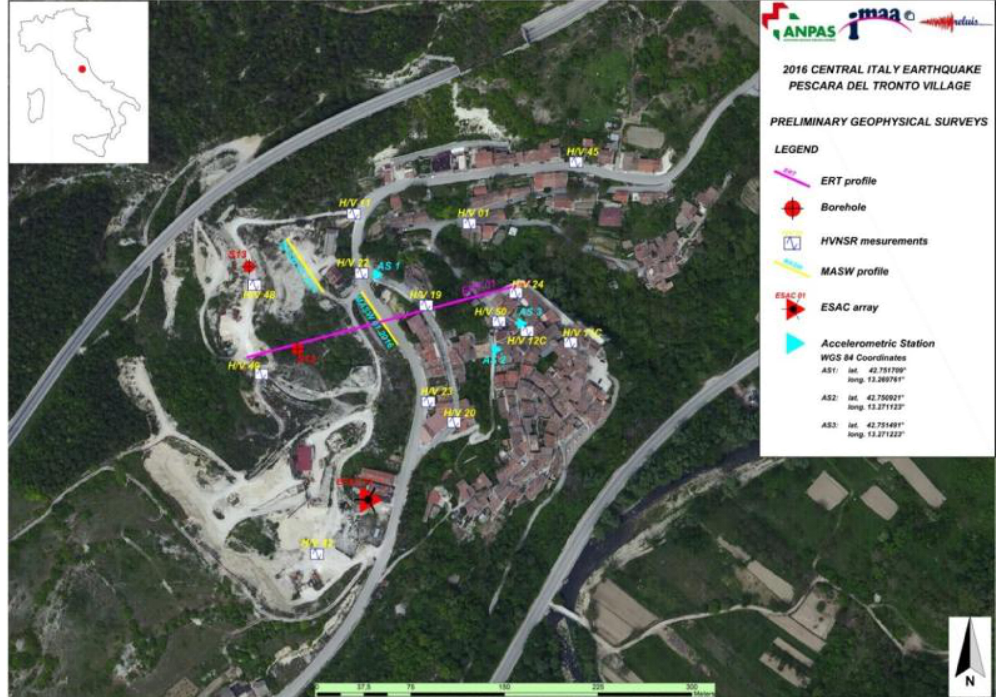
Figure 7: Sketch map of the investigated area at Pescara del Tronto with location of the geophysical surveys